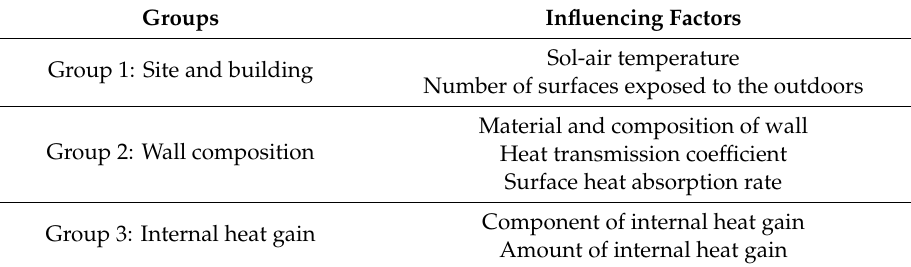
Table 4. Group and influencing factors in each group.